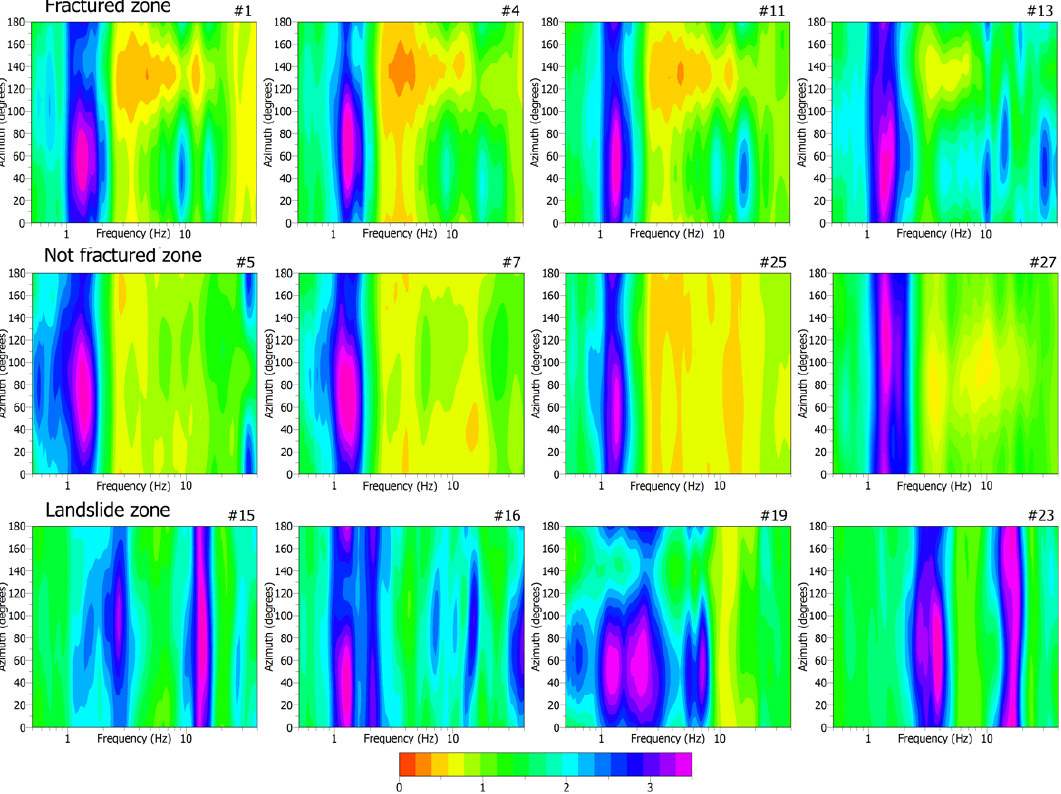
Fig. 9. Examples of the contours of the geometric mean of the spectral ratios as a function of frequency (x-axis) and direction of motion (y-axis) obtained at selected ambient noise recording